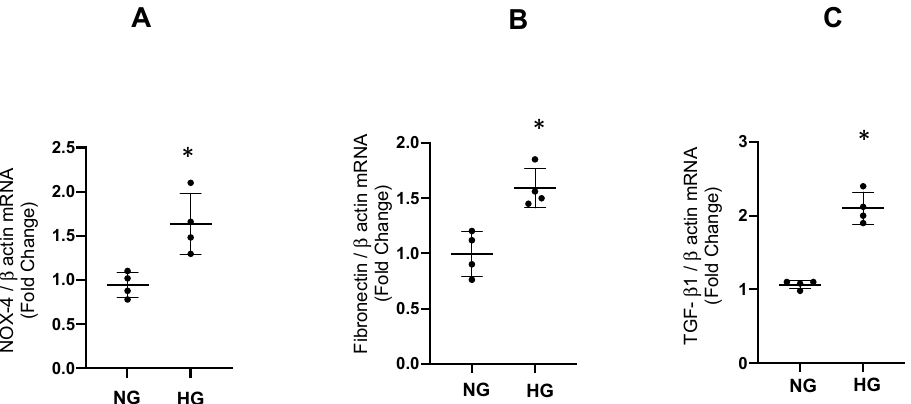
Figure 6. Expression of mRNA of NOX-4, fibronectin and TGF- β 1. The abundance of mRNA of NOX-4, fibronectin, and TGF- β 1 was augmented after 48 h of high glucose conditions (HG) as compared to normal glucose (NG) in IMCD cells. * p < 0.05 vs. control group, n = 4.